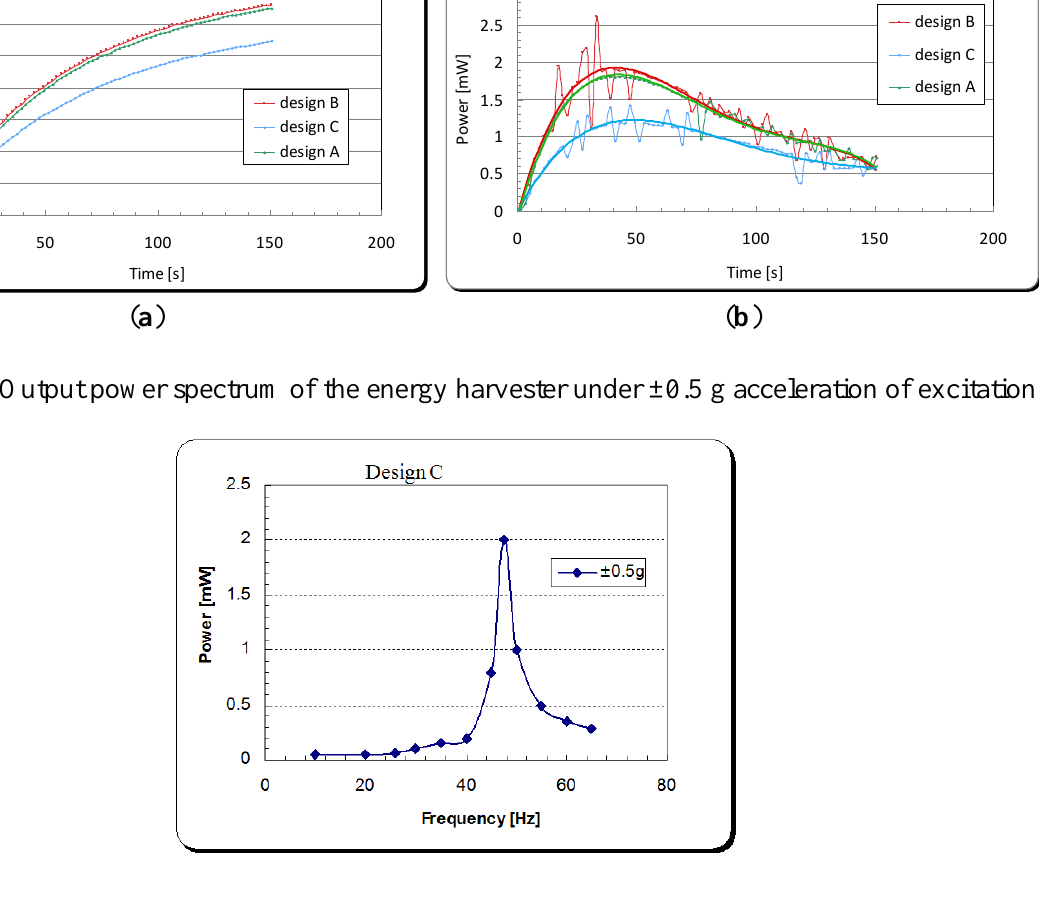
Table 5. Summary of the test results for the three vibration based energy harvester